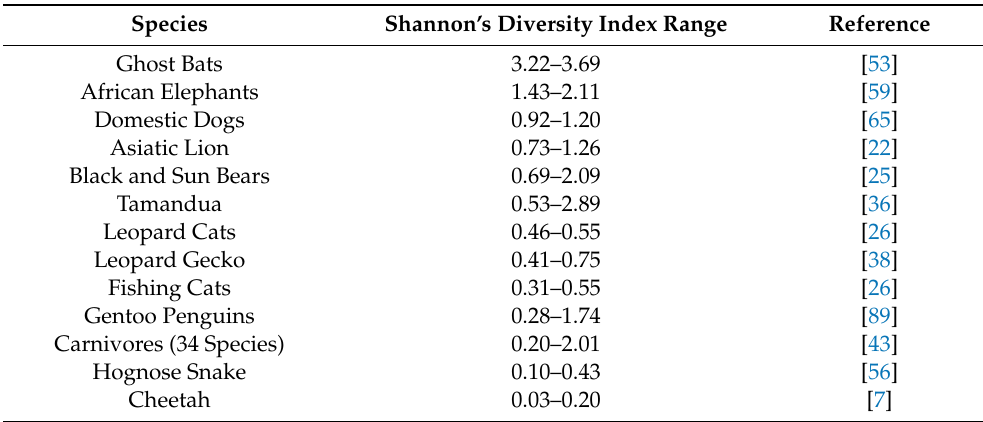
Table 2. Shannon’s diversity index scores across